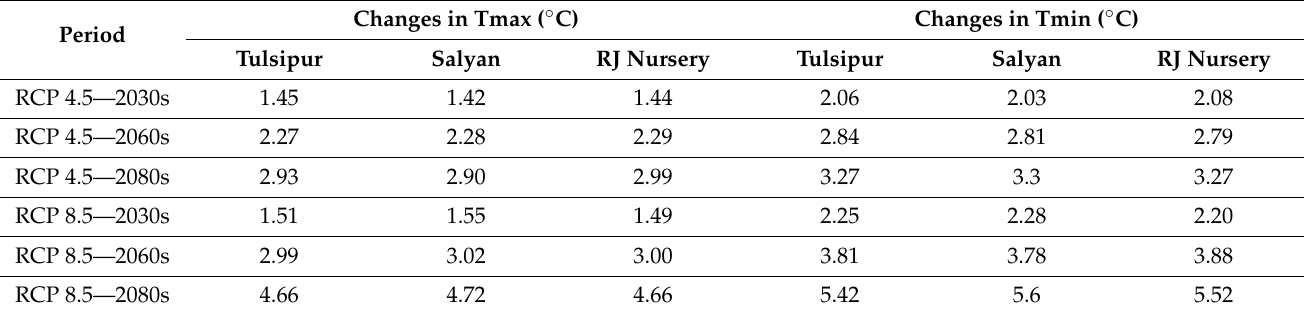
Table 5. Variations in annual Tmax and Tmin at different stations relative to the baseline period (1975–2005). Changes in Tmax ( ◦ C) Changes in Tmin ( ◦ C) Period Tulsipur Salyan RJ Nursery Tulsipur Salyan RJ Nursery